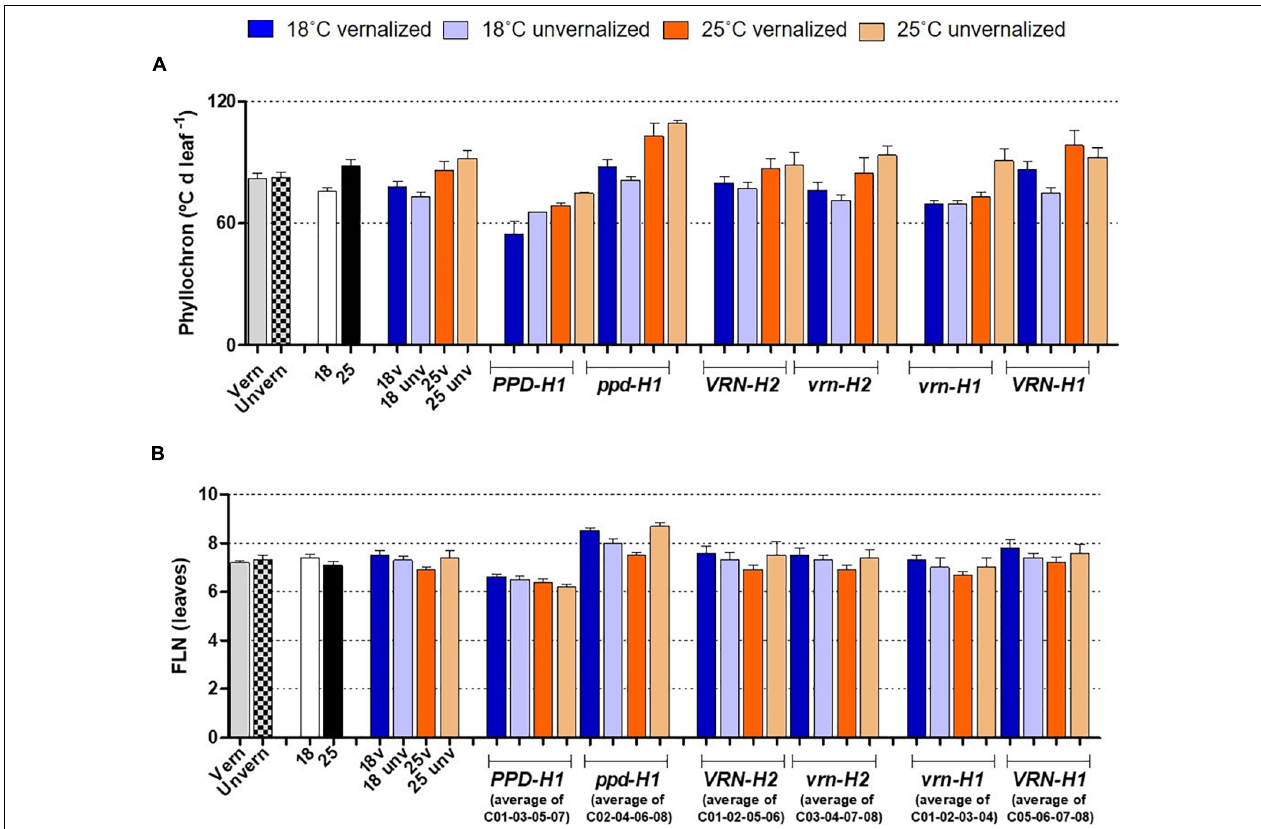
FIGURE 4 | Phyllochron (A) and final leaf number (B) , with genotypes averaged across classes. The first 8 bars on the left of each panel represent averages of the 8 barley NILs, split by treatments: vernalized and unvernalized, 18 ◦ C and 25 ◦ C, and the four treatments combining vernalization and temperature. The other bars represent averages of the 4 NILs carrying particular alleles at the three genes polymorphic in these NILs, as indicated in the legend of the X-axes: lines classified by PPD-H1 alleles; lines classified by VRN-H2 alleles, and lines classified by VRN-H1 alleles. Bars represent mean ± standard error of the mean (SE). Means were calculated without unvernalized C01 and C02 lines, which failed to reach Z31